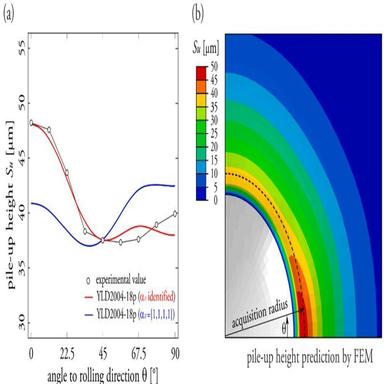
The result of inverse identification of the αII parameters: (a) The predicted pile-up height with optimal parameters (red curve) and predicted pile-up height with parameters αII = (blue curve). (b) The distribution of predicted pile-up height for optimal parameters by FEM simulation of IIT with acquisition radius shown with a dashed line.